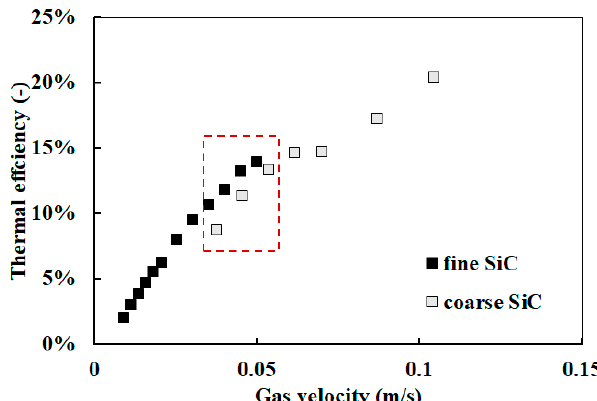
Figure 7. Effect of gas velocity on the thermal efficiency of particle receiver with different SiC.